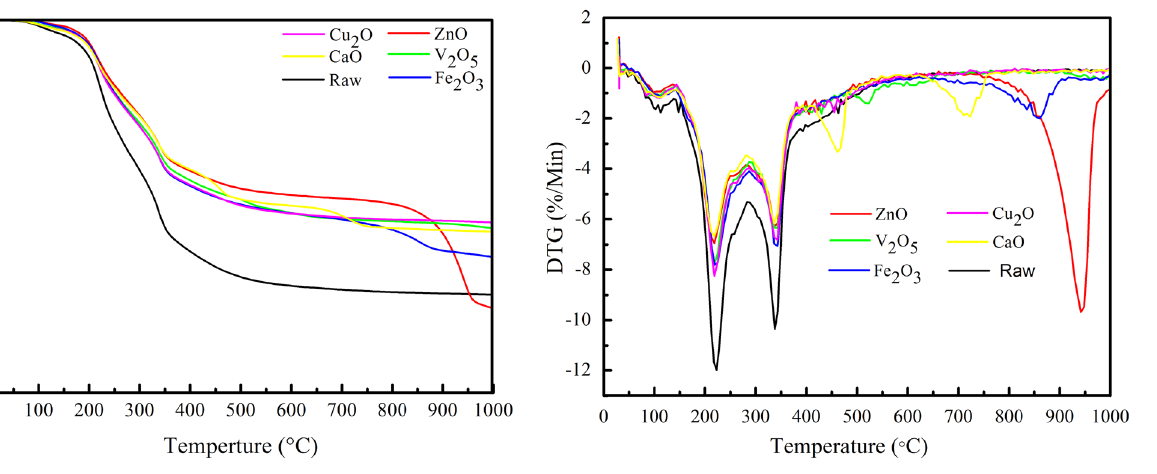
Figure 1: TG curves of dry navel orange peel for di ff erent metal oxides in argon atmosphere.